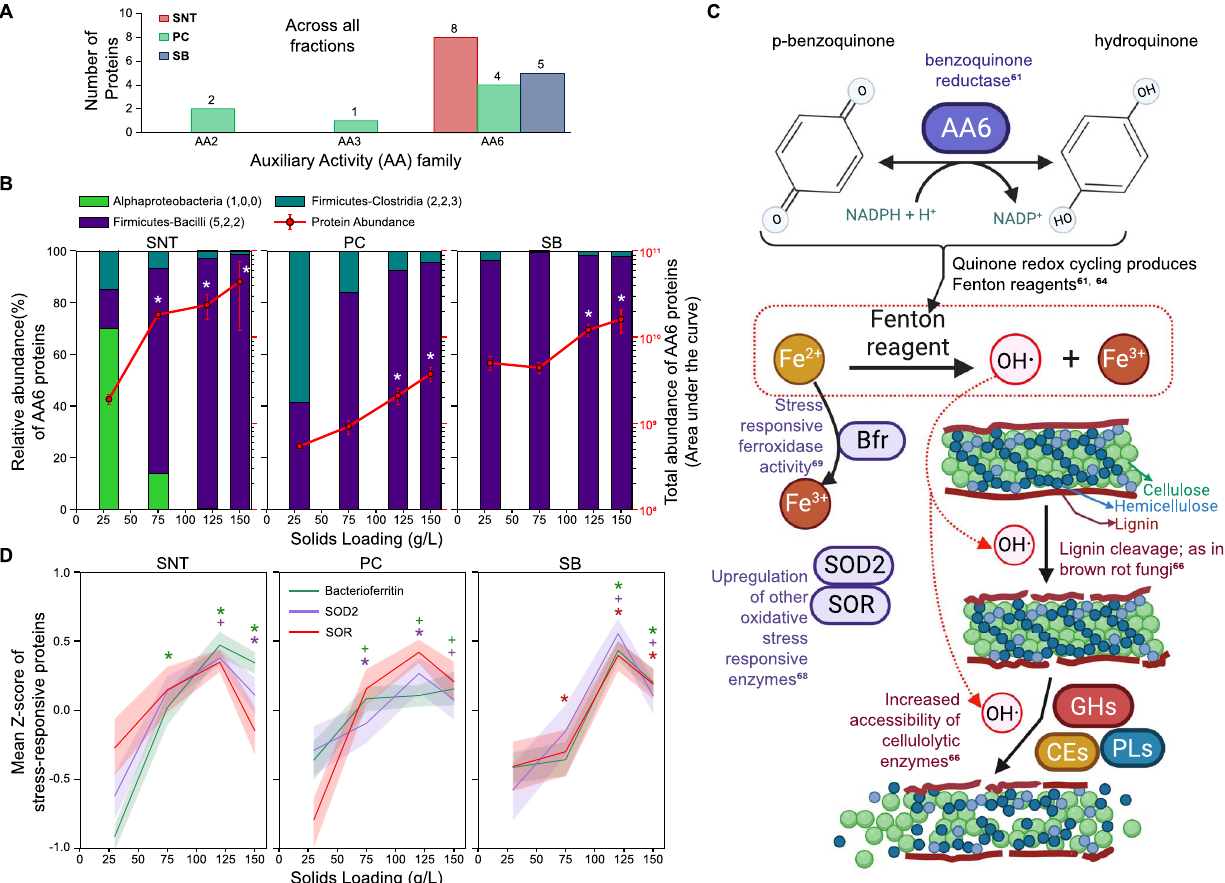
Fig. 4 The abundance of bacterial AA6 proteins as a function of higher solids loadings. A The number of proteins expressed from the different auxiliary activity (AA) families in each fraction. B The change in total abundance of AA6 proteins across solids loadings per fraction (right Y-axis, line plot) with relative abundance contributions by phyla (left Y-axis, bar plot). Error bars are ± standard deviation and * means two-tailed Welch ’ s t -test corrected p -value < 0.05 and absolute fold change ≥ 2× versus respective 30 g/L condition. C A proposed mechanistic hypothesis based on observed increases in protein abundances and known functions depicting the suggested role of AA6 proteins in enabling solubilization at higher solids loadings via ROS and Fenton chemistry. D The mean trends of proteins that are known to respond to oxidative stress across solids loadings per fraction. Bacterioferritin (Bfr; 18, 23, 20 proteins in SNT, PC, SB respectively), superoxide dismutase (SOD2;15,11,7) and superoxide reductase (SOR; 9, 10, 13). Mean Z-scores are shown with 50% con fi dence interval. + means two-tailed Welch ’ s t -test p -value < 0.05 and * means p -value < 0.05 and absolute fold change ≥ 2× versus respective 30 g/L condition. Exact p -values for each comparison are listed in Supplementary Data 9. SNT: supernatant, PC: planktonic cells, and SB: substrate bound fraction. Source data are provided as a Source Data fi